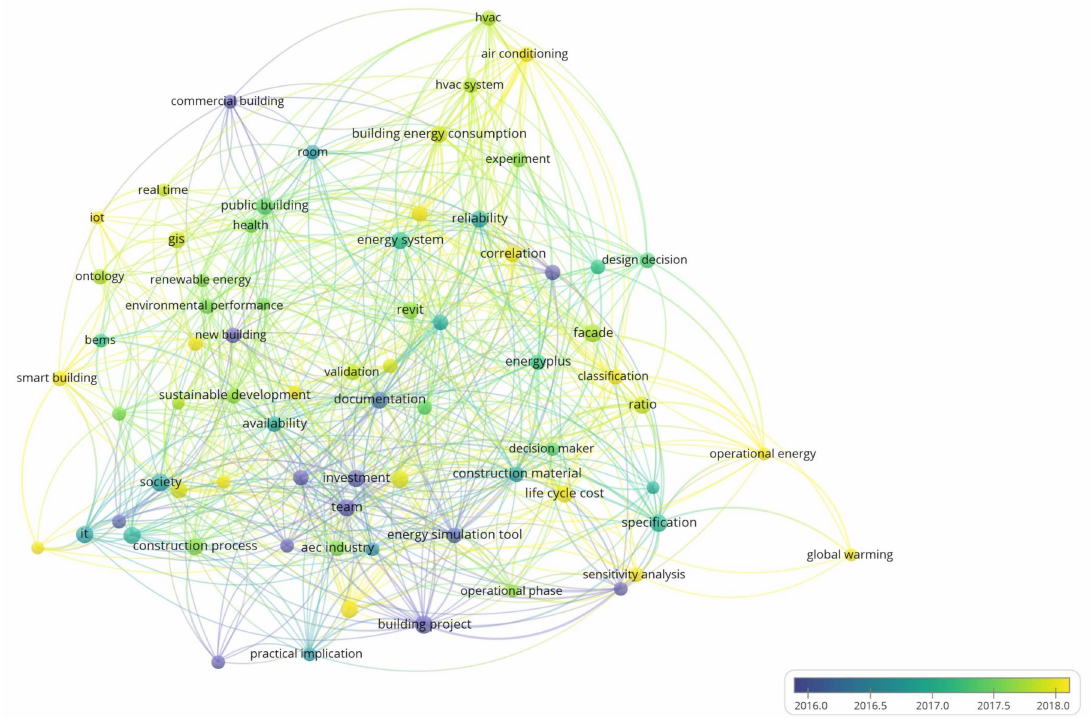
Figure 5. The least common keywords in BIM and building energy